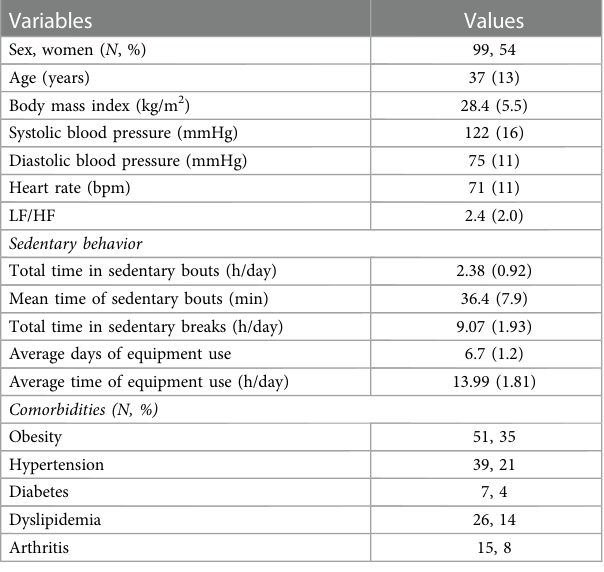
cuff for the arm circumference. Continuous measures were performed with 1 min of the interval among them, on the right arm, until arriving at a difference below 4 mmHg between two